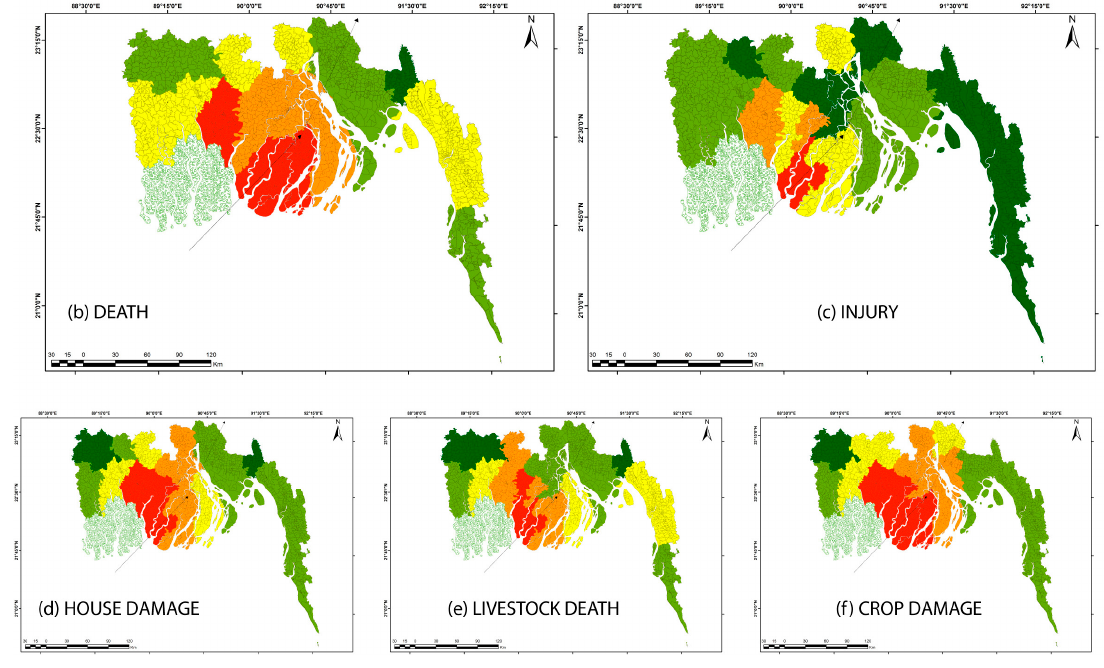
Figure 9. Map of impact of cyclone Sidr . Report of damage assessment of cyclone Sidr prepared by district commissioners were used to generate damage data and calculate damage index. Five components of loss or damage: ( b ) Death; ( c ) Injury; ( d ) house; ( e ) Livestock; and ( f ) crop have been ranked to the degree of damage and summed to produce the impact map ( a ).